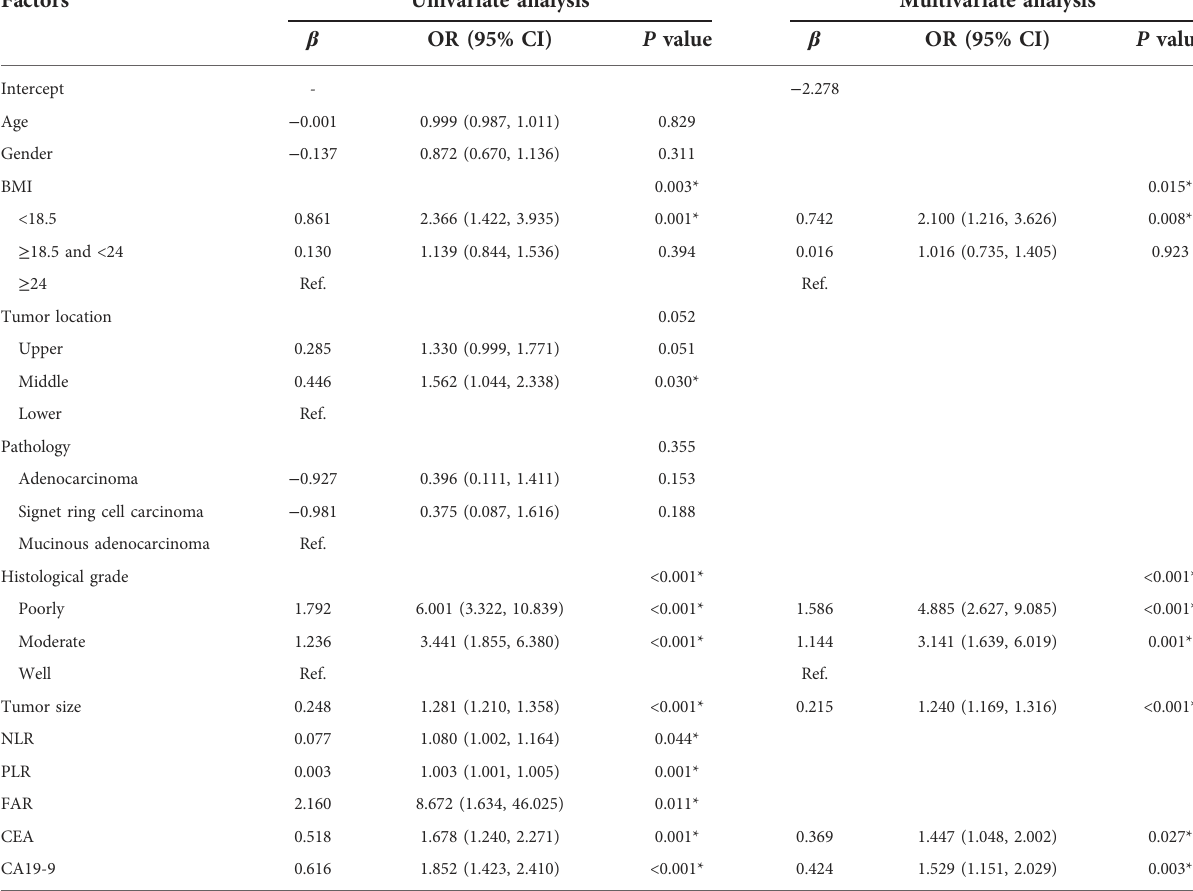
TABLE 2 Univariate and multivariate analysis of risk factors of LNM in